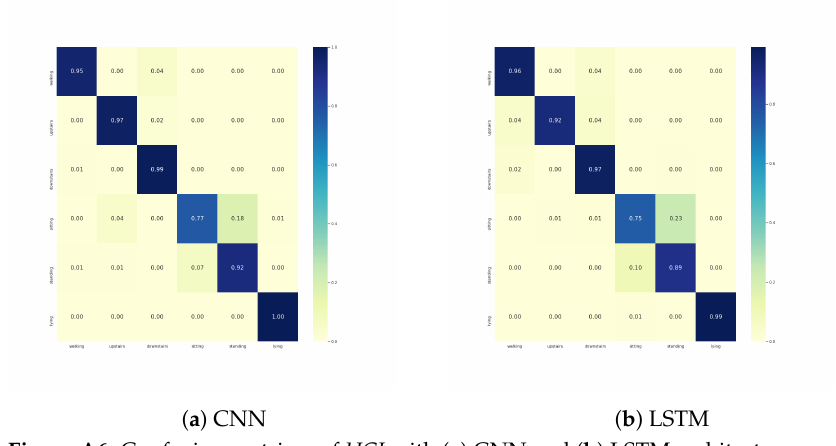
Figure A6. Confusion matrices of UCI with ( a ) CNN and ( b ) LSTM architectures. For PAMAP2 dataset the confusion matrix is given in Figure A7.